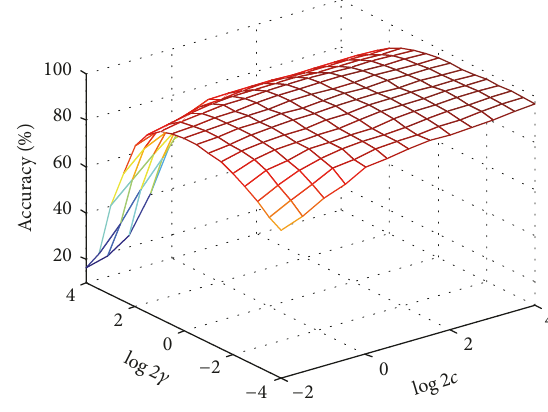
Figure 7: Principal components of PCA (Pareto).